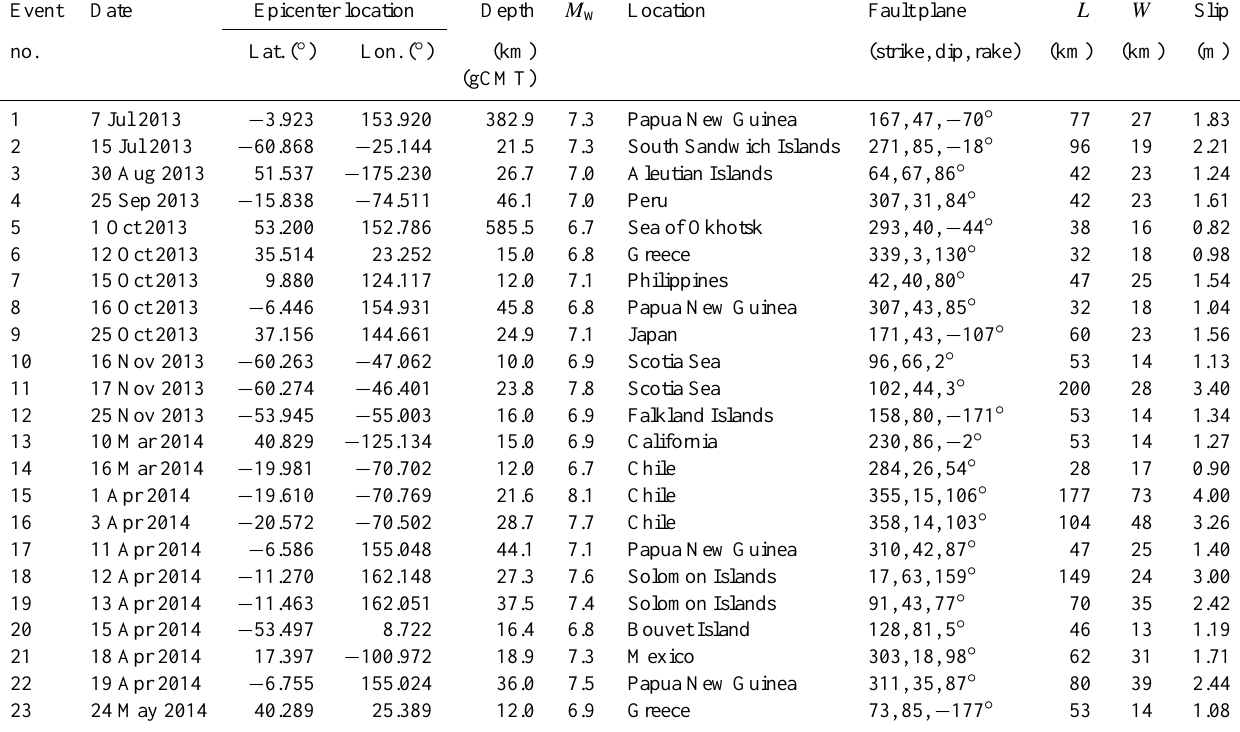
Table 1. Earthquake parameters for the 23 analyzed